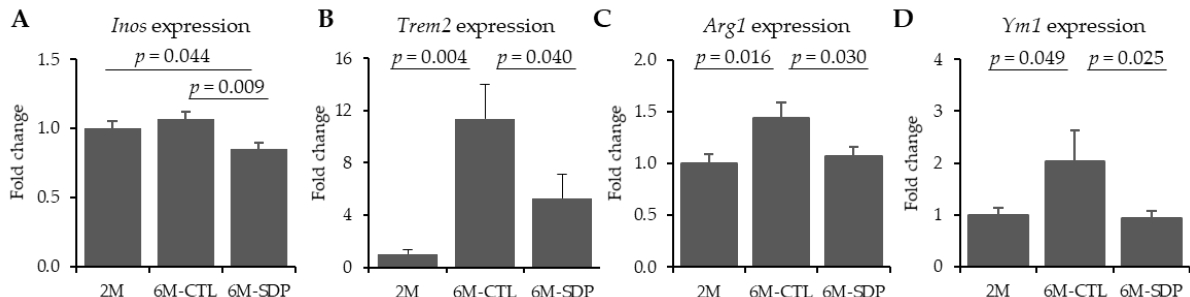
Figure 5. Effect of SDP supplementation on markers of microglia. Panels ( A – D ) show the gene expression of Inos , Trem2 , Arg1 , and Ym1 in cortex tissue, respectively. Results are expressed as mean ± SEM ( n = 5–6 mice). Statistics: one-way ANOVA followed by Fisher’s multiple comparison test. Inos: inducible nitric oxide synthase; Trem2: triggering receptor expressed on myeloid cells 2; Arg1: arginase 1; Ym1: chitinase-like protein 3 (Chil3).